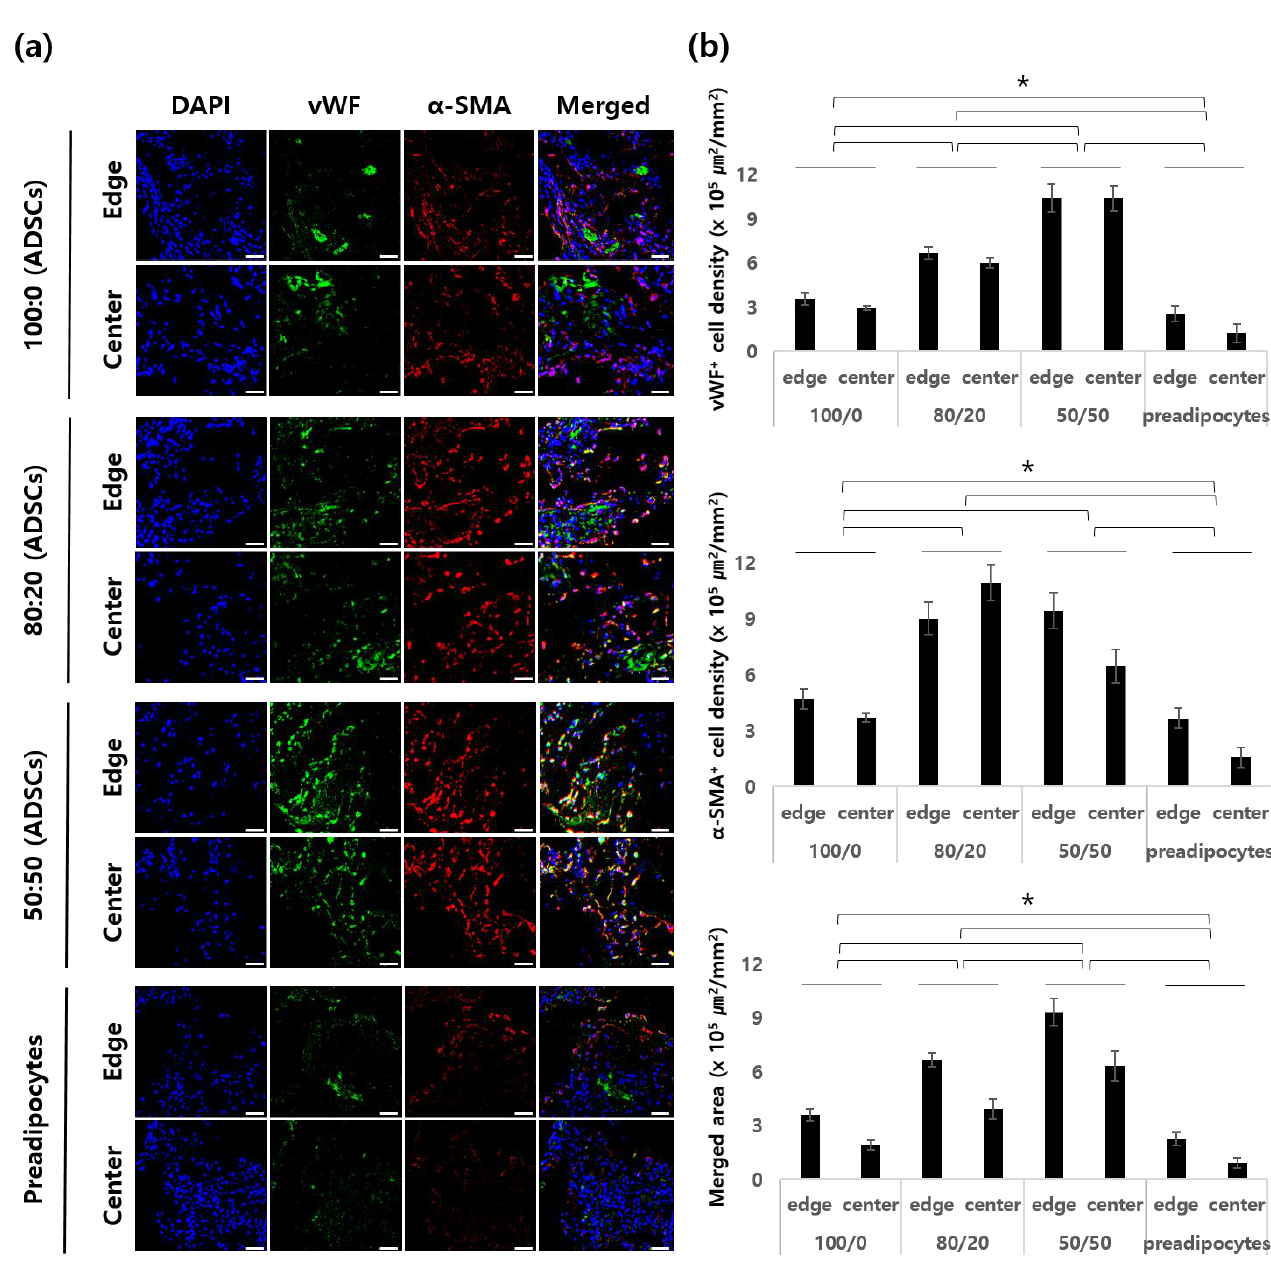
Figure 4. Angiogenesis in a construct. ( a ) Representative immunostaining of endothelial cells (ECs) and smooth muscle cells (SMCs) in each group 1 week after implantation. ( b ) Quantification of the vWF + cell density, α -SMA + vessel density, and merged area of vWF + and α -SMA + vessels (μm 2 /mm 2 ). Scale bar: 100 μm (* p < 0.05).